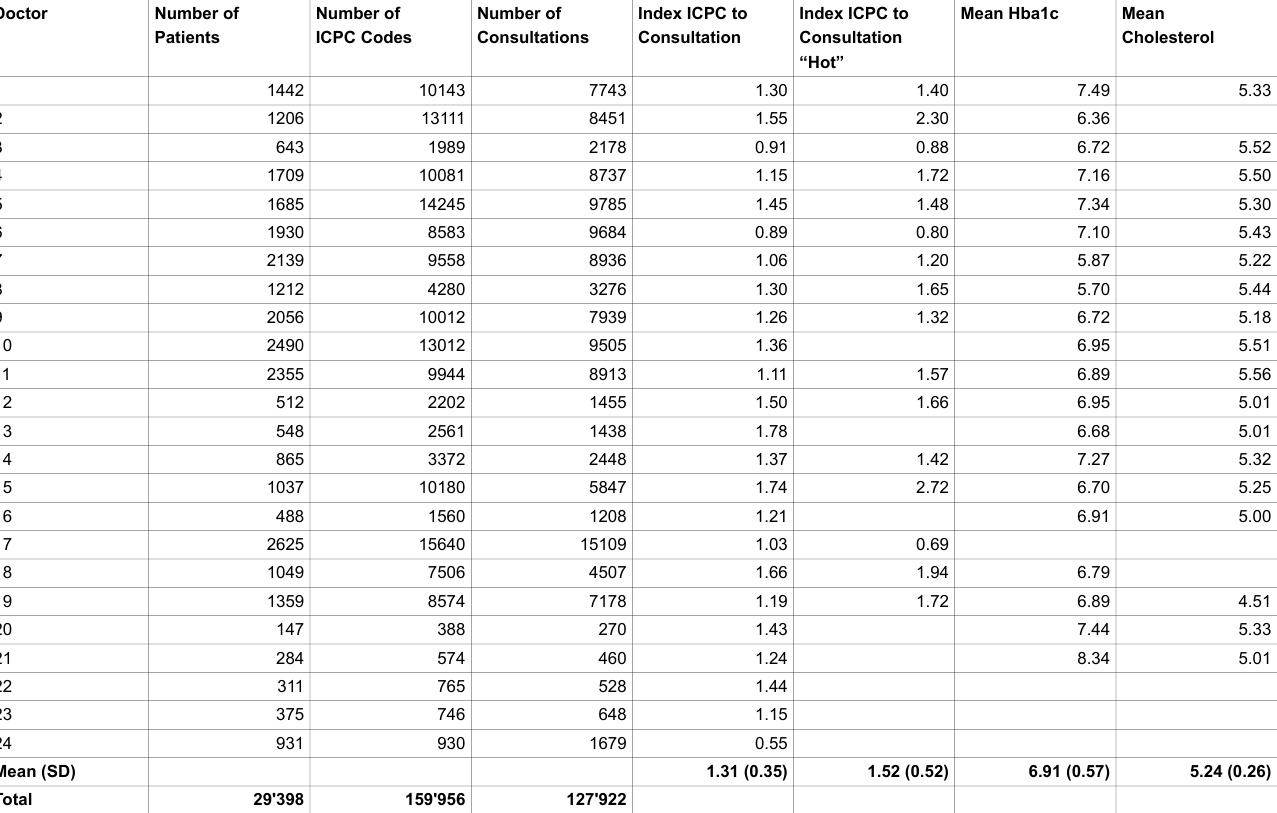
Table 1: Number of patients, ICPC-2-Codes, number of consultations per participant, ICPC to consultation index, ICPC to consultation index during the “hot-coding” week, Hba1c and cholesterol measurements. Doctor Number of Number of Patients ICPC